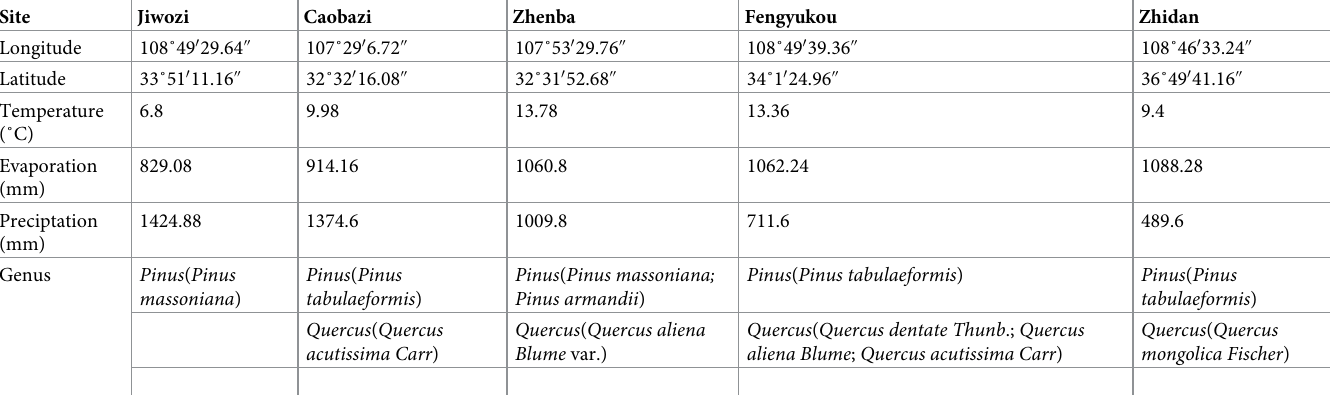
Table 1. Geographic and climatic parameters of the sampling sites (http://www.geodata.cn) [45].